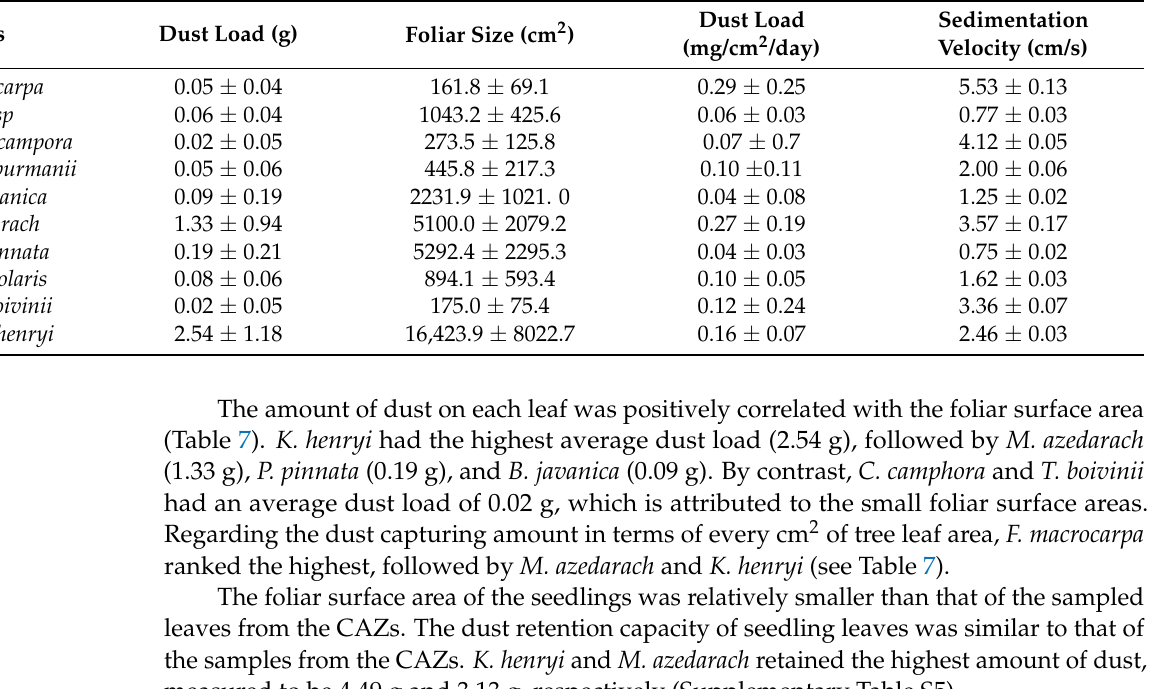
Table 7. Average dust load and foliar sizes on the sample CAZs in the north part of Taiwan. Species Dust Load (g) Foliar Size (cm 2 )